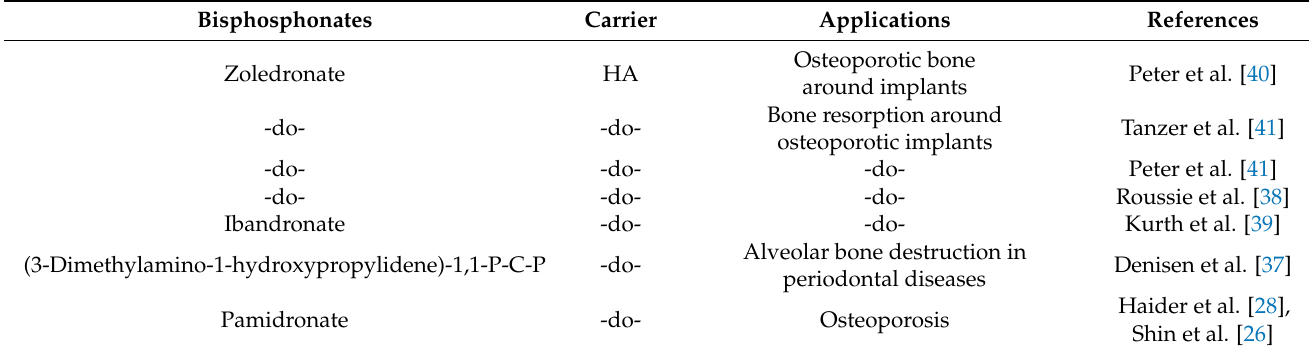
Table 1. Bisphosphonates in implant